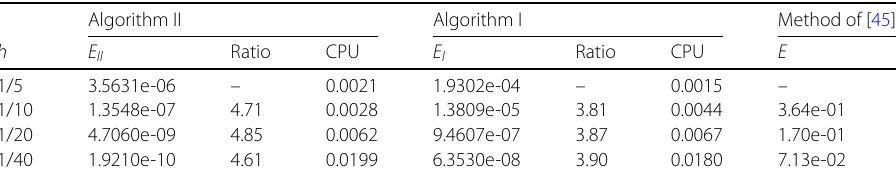
Table 1 The absolute errors of the presented algorithm I ( E I ), algorithm II ( E II ), and the numerical method of [45] for (31) with α = 0.1, ν = 4 Algorithm II Algorithm I Method of [45] h E II